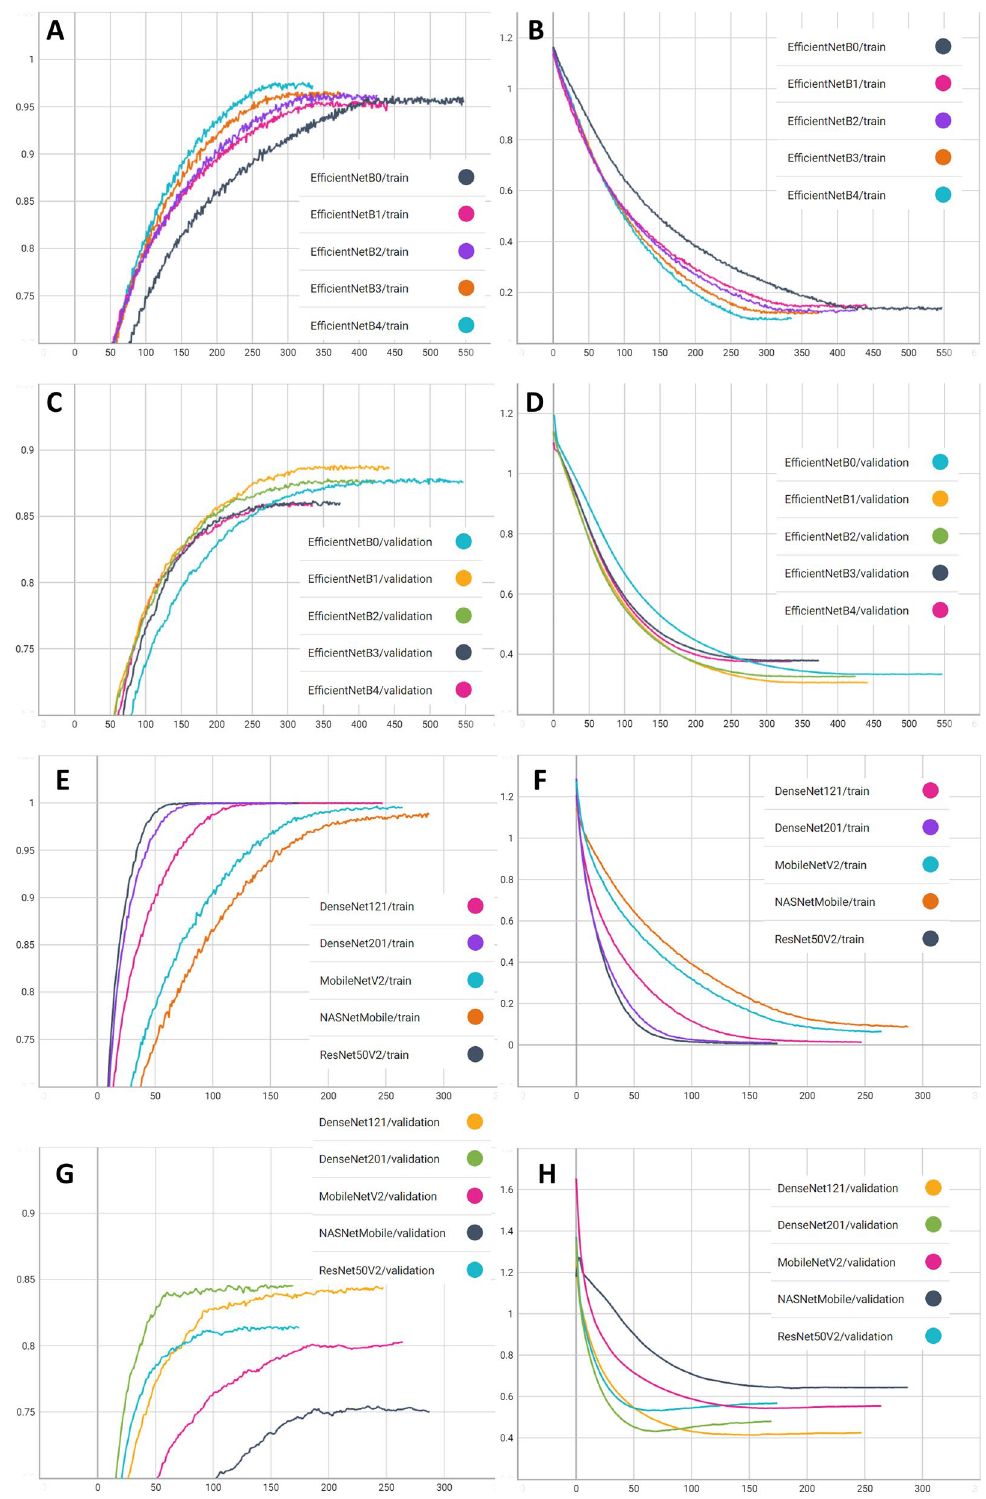
Figure 3. Performance metrics changes during the training process of each base model using a learning rate of 10 −6 . The horizontal axis represents the number of epochs. ( A ) training accuracies for the EfficientNet family; ( B ) training losses for the EfficientNet family; ( C ) validation accuracies for the EfficientNet family; ( D ) validation losses for the EfficientNet family; ( E ) training accuracies for models other than the EfficientNet family; ( F ) training losses for models other than the EfficientNet family; ( G ) validation accuracies for models other than the EfficientNet family; ( H ) validation losses for models other than the EfficientNet